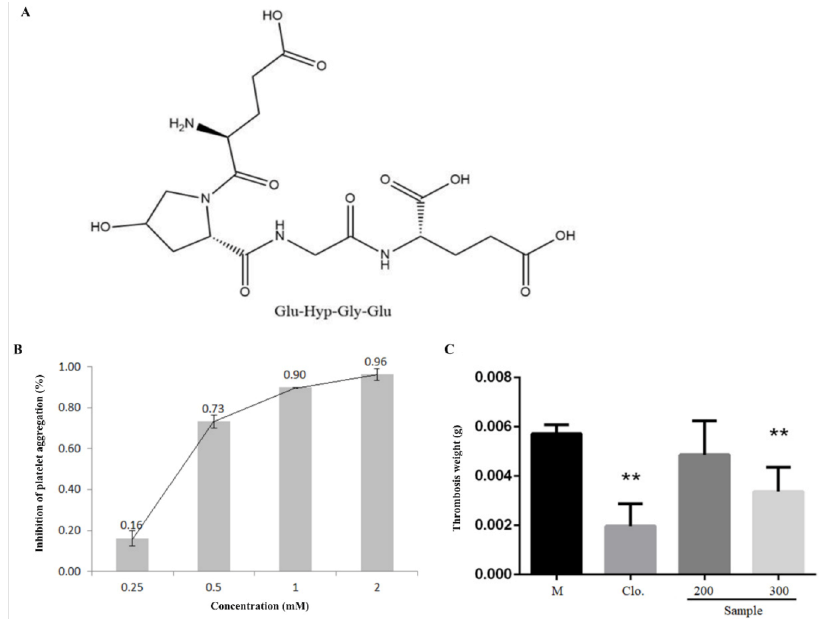
Figure 4. Peptide EOGE exhibited antiplatelet activity in vitro and prevented ferric chloride-induced arterial thrombosis in vivo. ( A ) Chemical structures of peptide EOGE. ( B ) Antiplatelet effect of peptide EOGE induced by ADP. ( C ) Effects of peptide EGOE on ferric chloride-induced arterial thrombosis model in rats, with clopidogrel as positive control. Male Sprague Dawley rats were orally administrated with 0.9% saline, clopidogrel, EGOE at different doses ( µ mol/kg b.w.), respectively. ** indicates p < 0.01 as compared to the M group ( n =